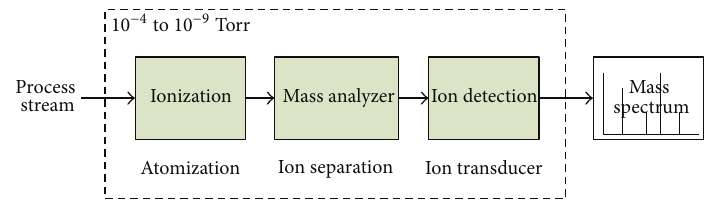
Figure 1: Schematic of mass spectroscopy